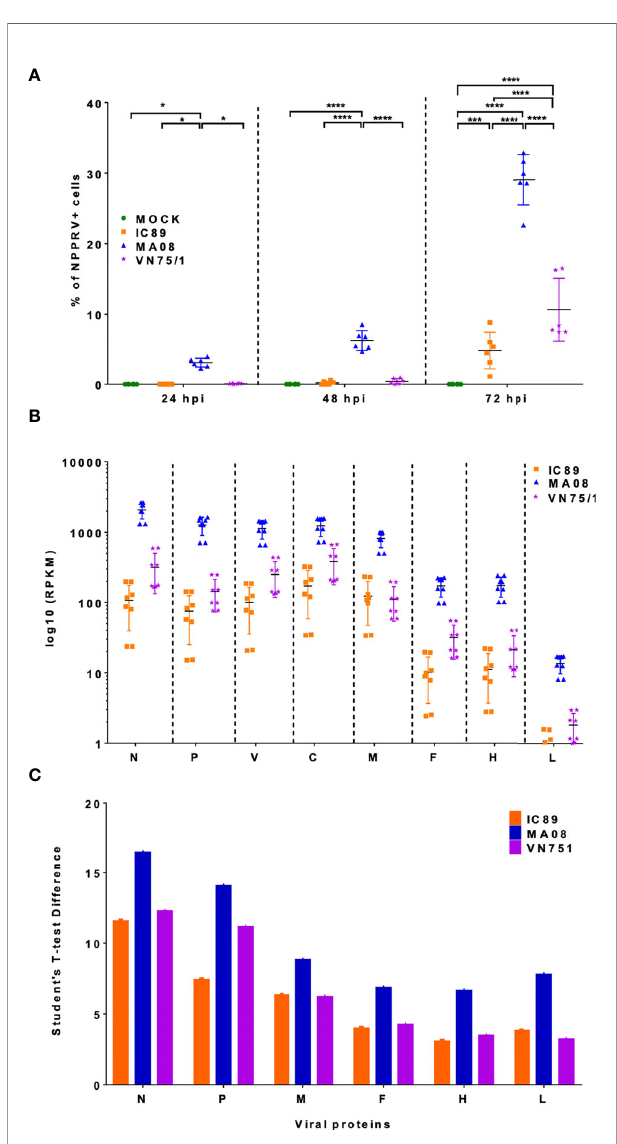
FIGURE 2 | Detection of viral genes and proteins during PPRV infections of PBMCs. (A) Detection of PPRV N-nucleoprotein positive cells by fl ow cytometry. P-values were calculated using two-way ANOVA. (B) Distribution of mapped reads of viral genes in RNA sequencing data at 72 hpi. (C) Viral proteins accumulated at 72 hpi and detected by mass spectrometry. Five goats were used to obtain PBMCs. The sixth point observed in 2A represents an additional experiment performed on one animal to con fi rm the results obtained. P-values were calculated using two-way ANOVA: “ * ” = P-values < 0.05; “ *** ” = P-values < 0.001; “ **** ” = P-values <